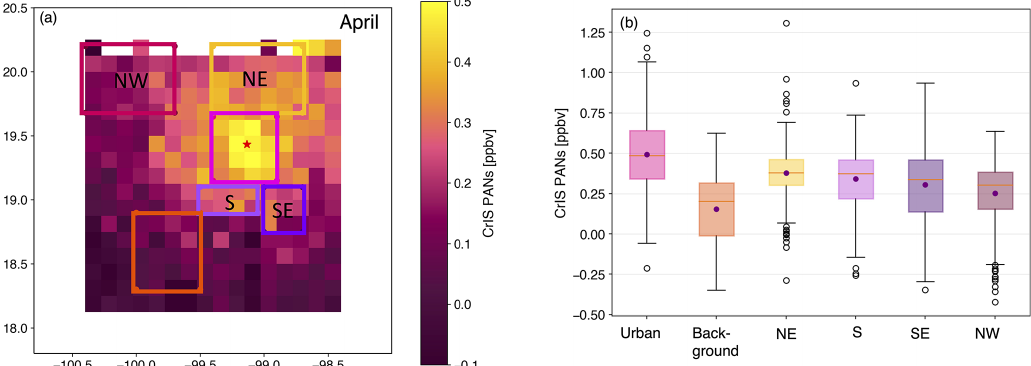
Figure 4. (a) Potential air pollutant outflow regions for the Mexico City basin (colored squares) plotted over monthly mean gridded CrIS PANs for April 2016–2021, (b) boxplots of daily CrIS free-tropospheric PANs measurements within the boxes shown in (a) . The orange lines and purple circles represent the median and mean, respectively. The whiskers represent the standard deviation of daily CrIS free-tropospheric PANs